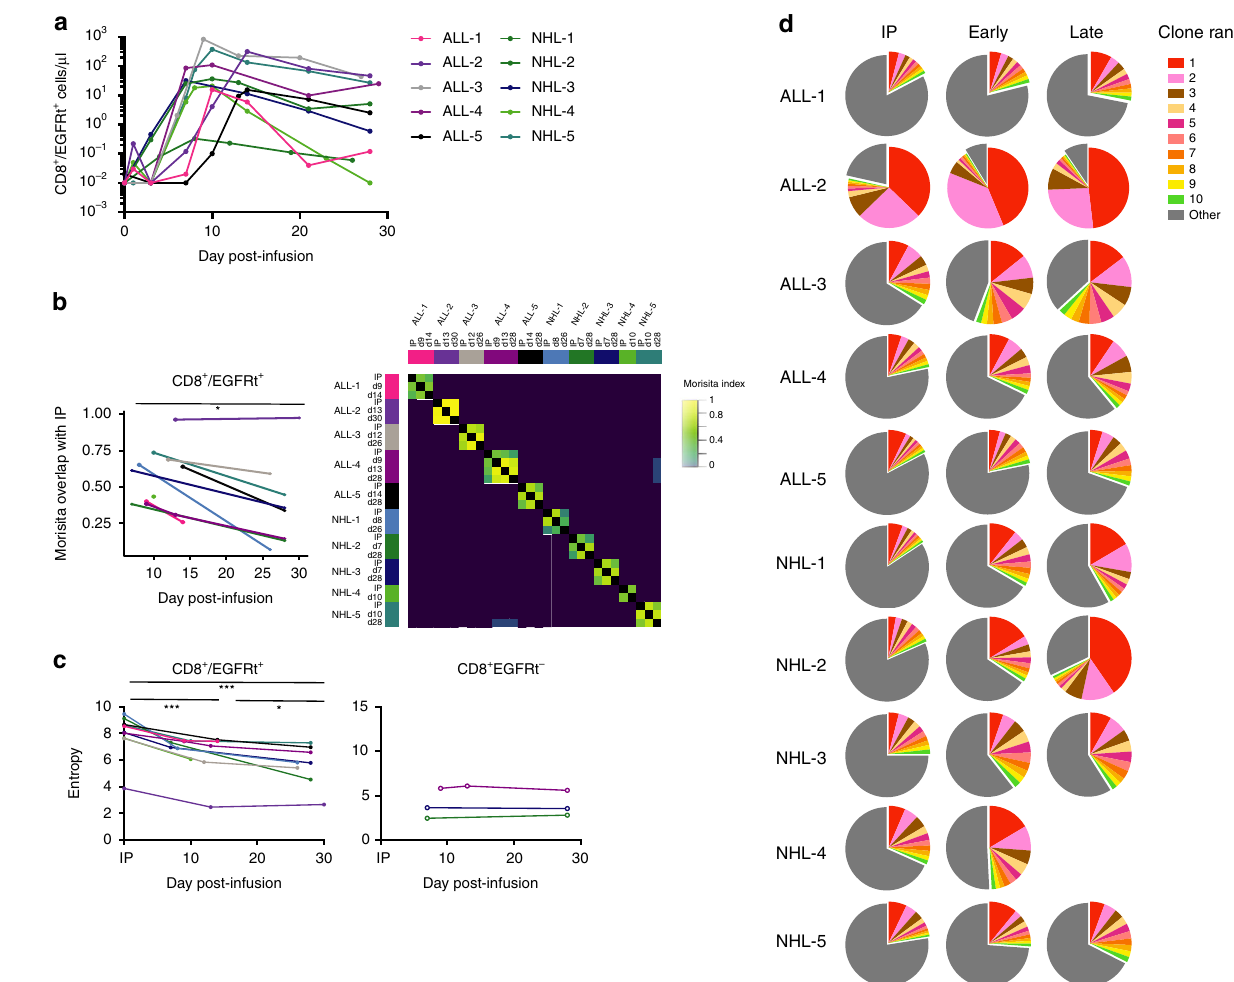
Fig. 1 Clonal diversity of CD8 + CAR-T cells decreases after infusion. a CD8 + /EGFRt + CAR-T cell counts in the blood of patients who received CAR-T cells manufactured from CD4 + and CD8 + T CM cells ( n = 10 patients). Data represents the mean ± SEM. ALL acute lymphoblastic leukemia, NHL non- Hodgkin lymphoma. b The Morisita index was calculated for pairwise comparisons of the CD8 + CAR-T cell repertoire between all samples. Left, Morisita overlap index between the IP and the indicated times after adoptive transfer. Each line represents data from an individual patient. Right, heatmap of the Morisita index. The Morisita index was lower at late compared to early times after infusion (paired Mann – Whitney test, p < 0.05). c Decreased clonal diversity in CD8 + CAR-T cells after infusion. The Shannon entropy indices of the CD8 + /EGFRt + (CAR-T cell, left) and CD8 + /EGFRt − (non-CAR- expressing T cell, right) TCRB repertoires are shown. Statistical differences between samples were evaluated with paired t -tests. * p < 0.05, ** p < 0.005, *** p < 0.001. d The relative frequencies of the top ten ranked clonotypes in the total CD8 + CAR-T cell TCRB repertoire in the IP and at the early and late time points after infusion are presented in pie charts. The top ten clonotypes are ranked by the number of copies of the TCRB sequence in each sample; the same color might not represent the same identical clonotype at each time point. Source data underlying Fig. 1a, c, and d are provided as a Source Data fi